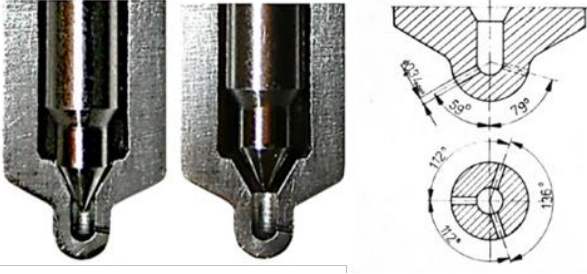
Fig. 1. Geometric parameters of D1LMK 148/1 atomizer used at the test stand Table 1. Geometric parameters of slots of the atomizer D1LMK 148/1 No.